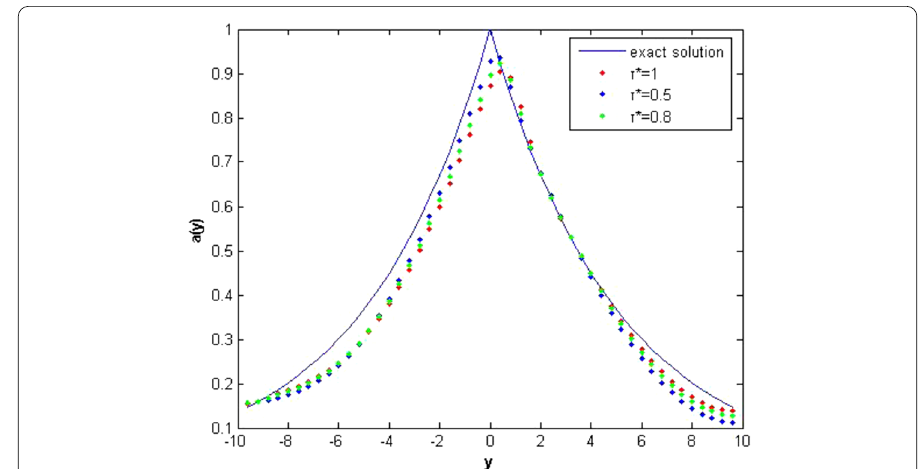
Figure 2 Identified drifts for Example 2 (iterative number 300)